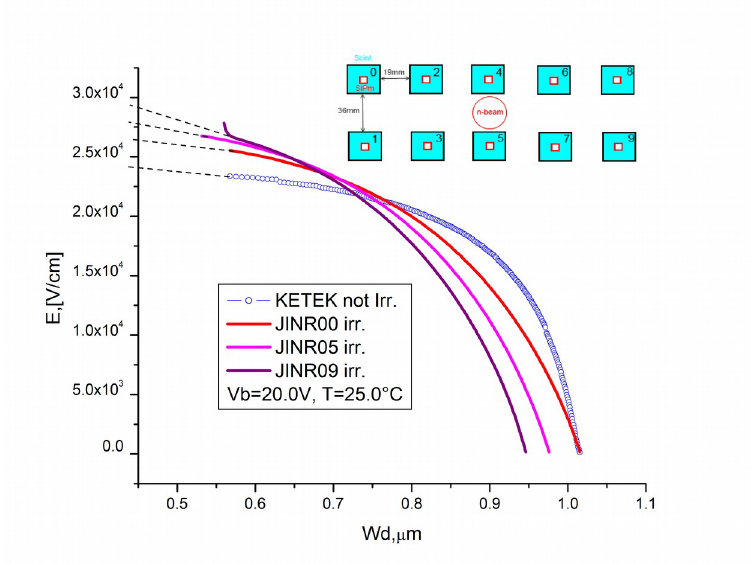
Figure 1. Electric field into SiPM depletion region for irradiated and not irradiated detectors (T=25 ° C, Vbias=20V)